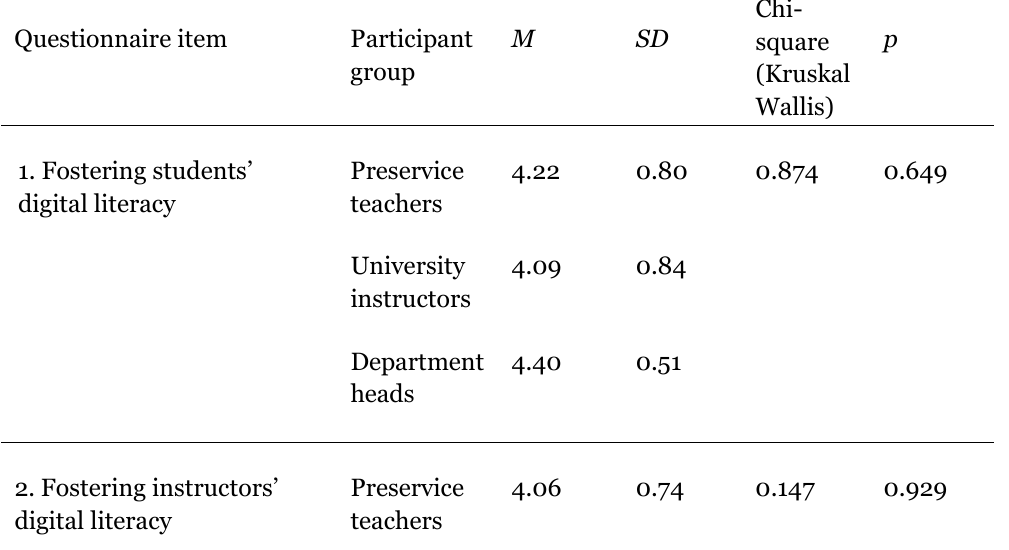
Questionnaire Results on Measures to Improve the Acceptance of Online TEFL Courses